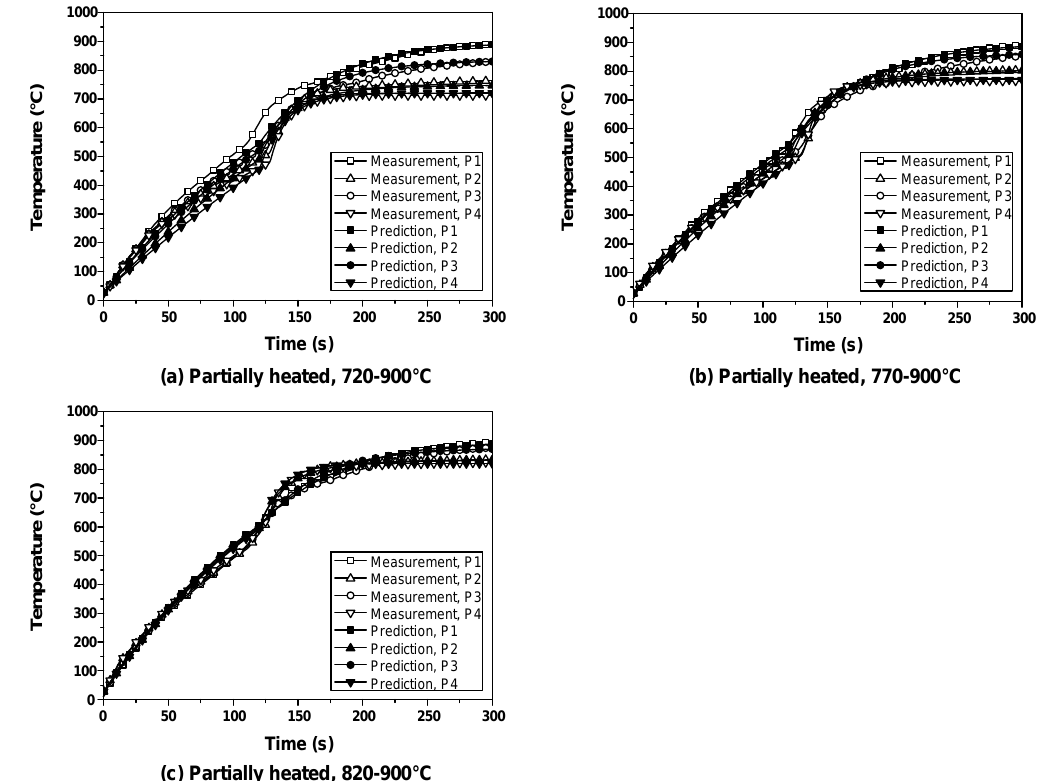
Figure 12. Comparison of the heating histories between the measurement and prediction. In all areas of the high-strength region, the volume fraction of martensite was 96.9%, owing to the short holding time at the heating stage. The volume fraction of martensite in the low-strength region increased from 1.2% to 67.2% as the heating temperature increased, and that in the transition zone increased as the measuring point moved closer to the high-strength region. The predicted volume of <4.52%, according to Equation